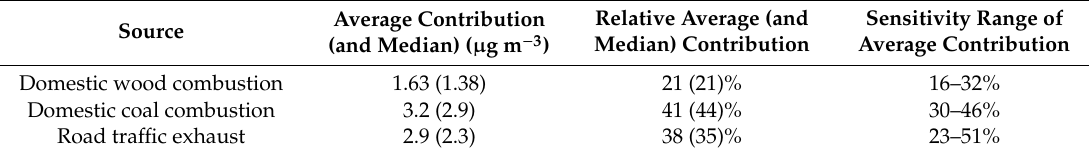
Table 2. Average and median contributions from sources to CM at Diab ł a Góra and the relative contribution. The range of values for the average contribution as obtained from the sensitivity analysis described in Section 3.2, is also shown.